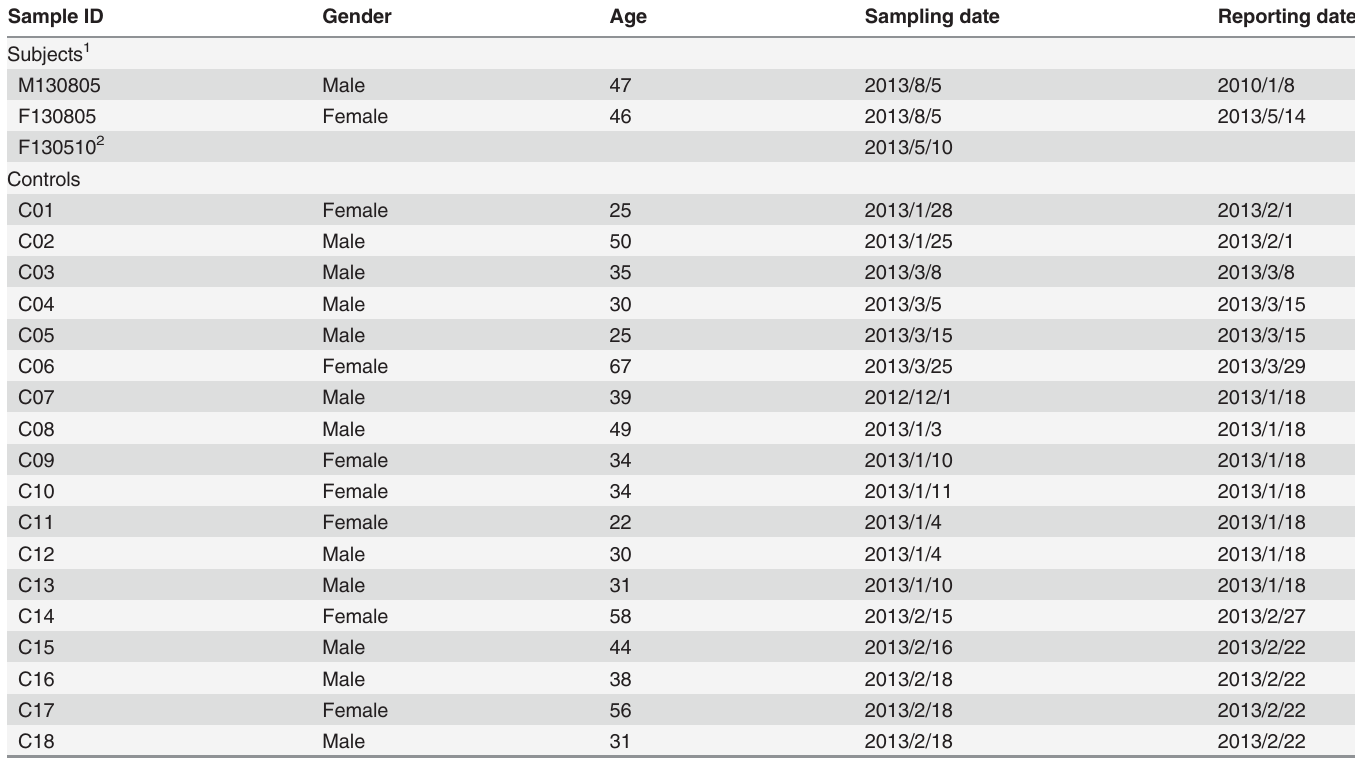
Table 1. Samples